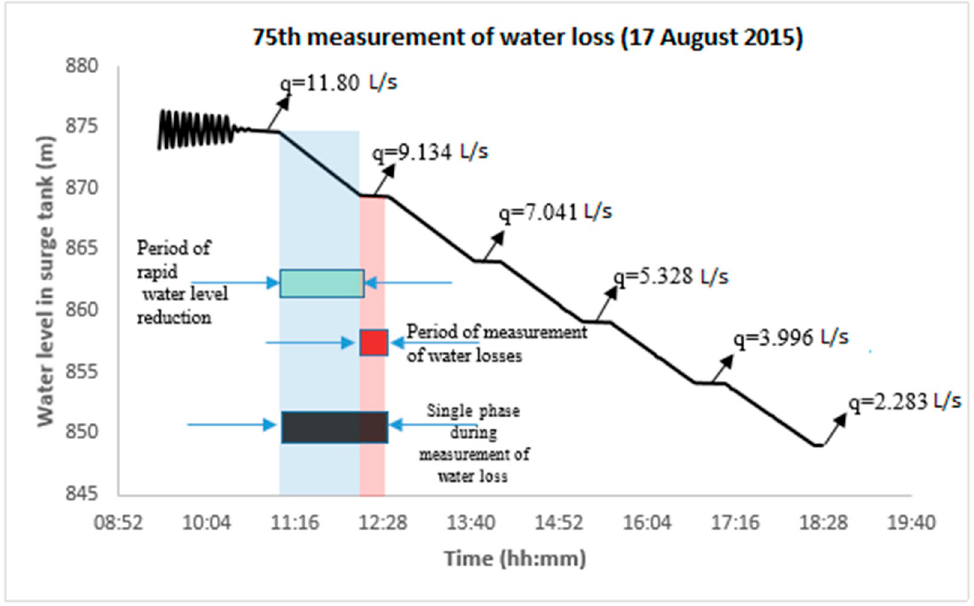
Figure 4. Water level change in surge tank during the measurement of total water losses (75th session).